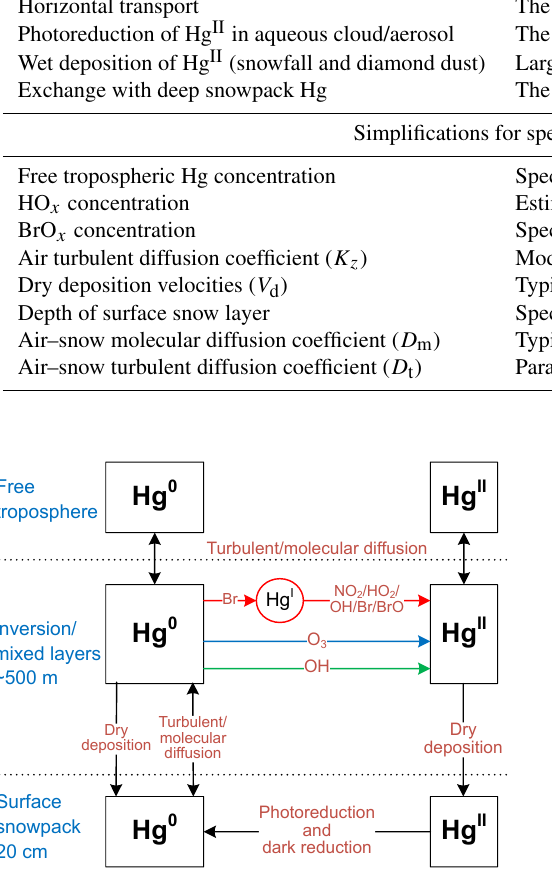
Figure 1. Chemical and physical processes represented in the mer- cury box model. Hg 0 can be oxidized to Hg II by three different gas-phase chemical schemes (OH, O 3 , or a two-step Br-initiated scheme). Note that the concentrations of the intermediate Hg I in the two-step Br-initiated oxidation mechanism are not tracked since its lifetime is short, and thus effective reaction rates are used to de- scribe the oxidation of Hg 0 to Hg II for this mechanism (Sect. 2.3). The dark reduction of surface snow Hg II may be only important for the non-summer period (Sect.